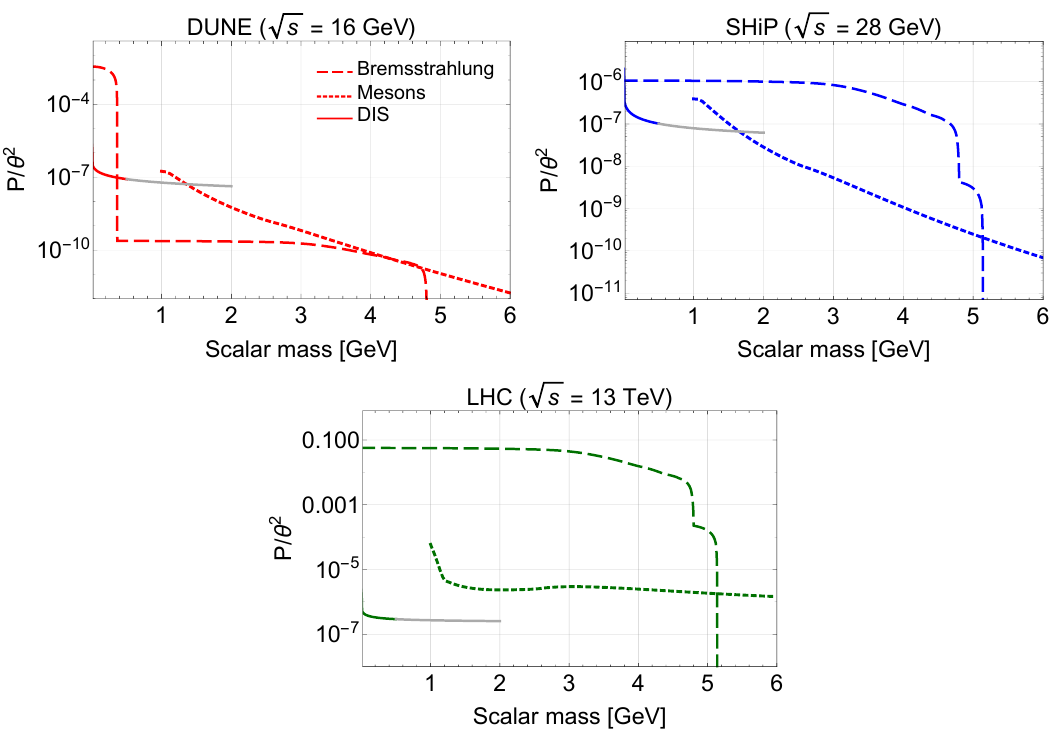
Figure 6 . The probabilities of a scalar production in proton bremsstrahlung process (2.1) (solid lines), DIS process (2.2) (dotted lines) and decays of B mesons (dashed lines) versus the scalar mass. \LHC", \SHiP" and \DUNE" denote correspondingly results for the proton-proton center- of-mass energies p s pp = 13 TeV, p s pp = 28 GeV and p s pp = 16 GeV. The gray line corresponds to the extrapolation of the bremsstrahlung production probability assuming unit value of the proton elastic form-factor, see text for